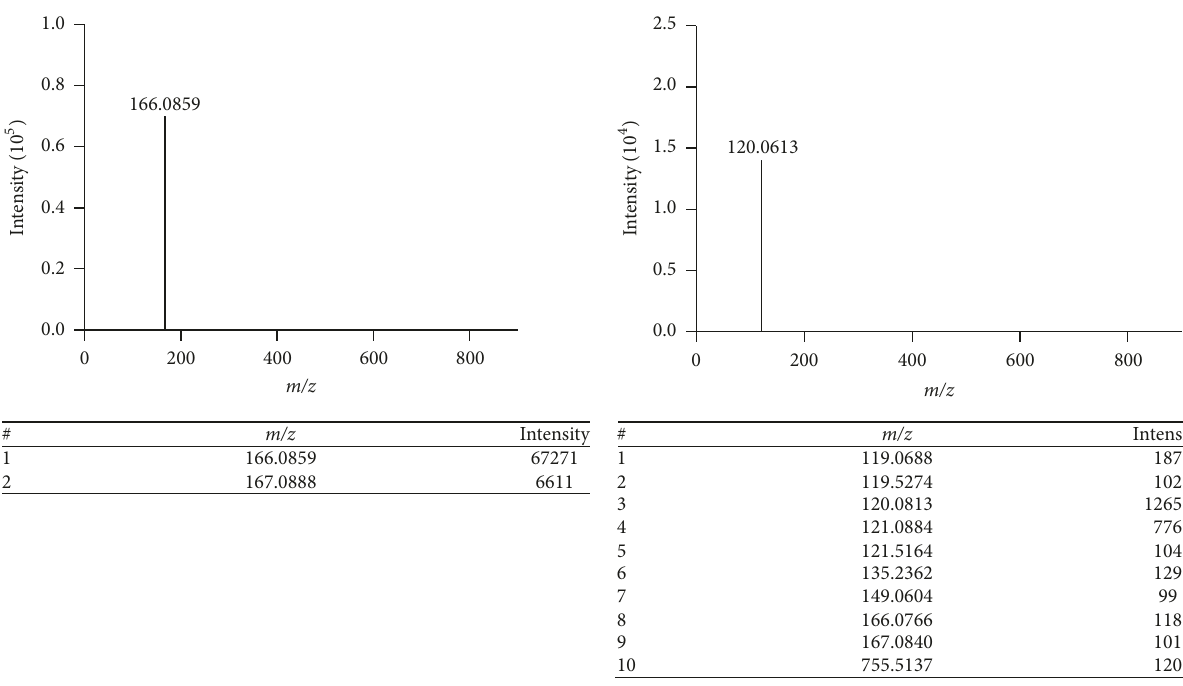
Figure 5: The 𝑚/𝑧 and intensity value of phenylalanine on day 1.